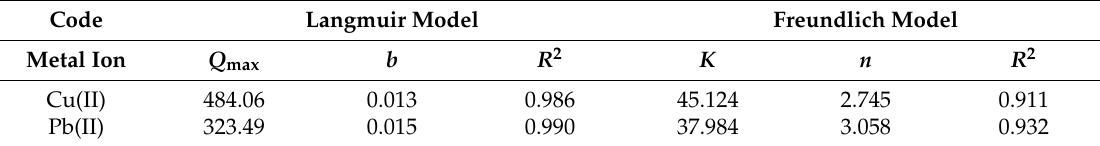
Figure 9. ( a ) and ( b )Adsorption capacity of the x CNC/CS/PVA-SH nanofibrous films for metal ions under different concentration and adsorption isotherms; ( c ) The mechanism of adsorption of M(II) on nanofibrous films. Table 2. Fitting parameters of adsorption isotherm